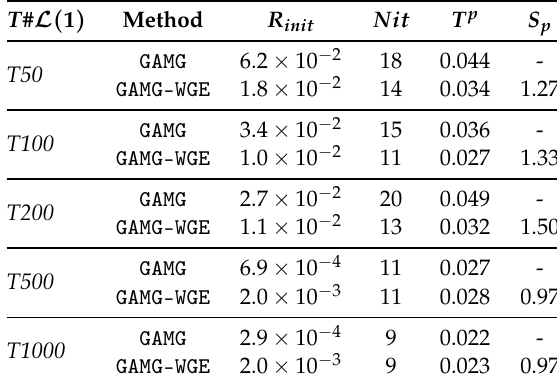
Table 1. Test result of some linear equation systems in pitzDaily † .